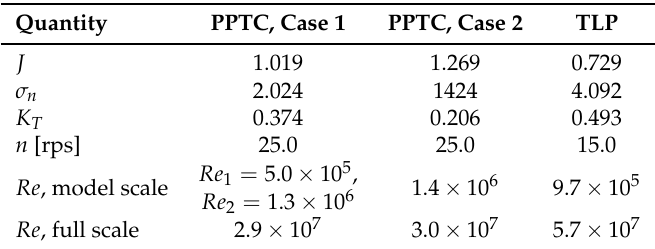
Table 3. Test conditions for the cavitating cases.